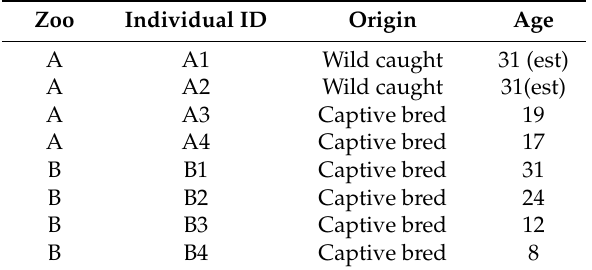
Table 1. Subjects demographics. Elephants are listed individually with origin and age at the time of the